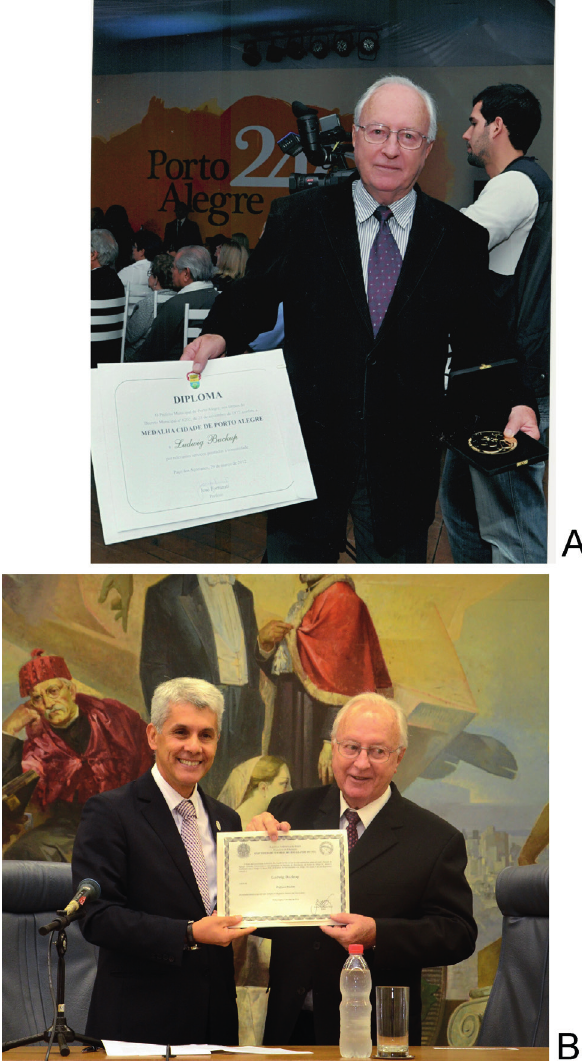
Figure 2. Special recognitions received by Ludwig Buckup. A, Ludwig Buckup receiving the “Medalha Cidade de Porto Alegre” (2012); photograph of L. Buckup’s personal collection. B, Ludwig Buckup receiving from Dr. Carlos Alexandre Netto, Rector of UFRGS, Honor to Merit at the Federal University of Rio Grande do Sul (2016); photograph: Gustavo